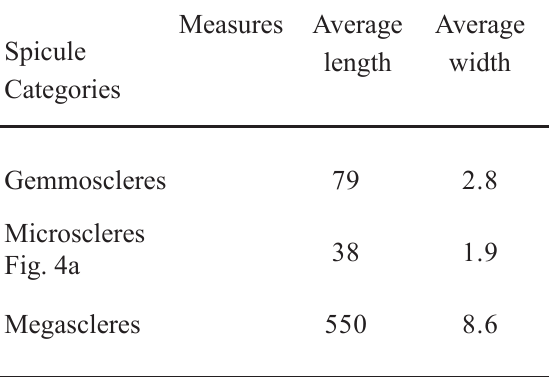
Category and measures (µm) of spicules of D. pydanieli detected in the three studied sections. All categories are